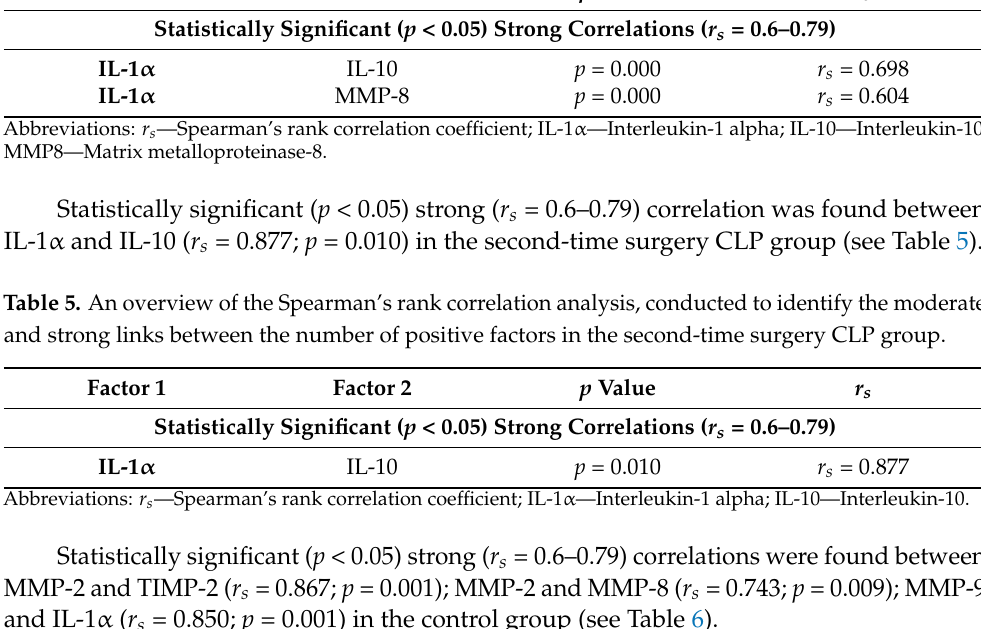
Table 4. An overview of the Spearman’s rank correlation analysis, conducted to identify the moderate and strong links between the number of positive factors in the first-time surgery CLP group. Factor 1 Factor 2